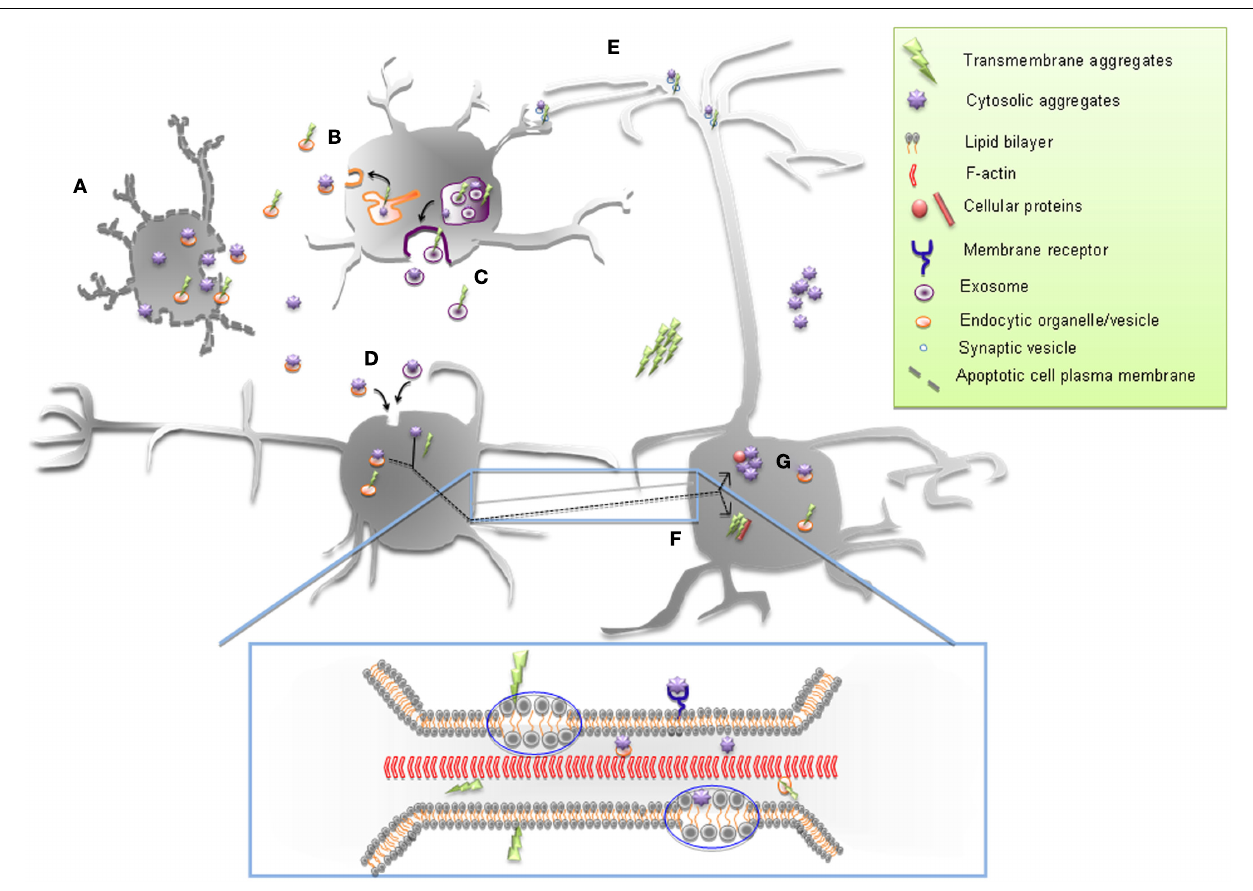
occur within endocytic vesicles or as aggresomes. “Surfing” on theTNT membrane could also occur: for transmembrane aggregates through their membrane attachment and for cytosolic aggregates either within the cytosolic leaflet of theTNT or along the external leaflet in association with a membrane-receptor. Once inside the recipient cell, proteinaceous aggregates can then seed aggregation of the cytosolic or transmembrane cellular counterpart (G)